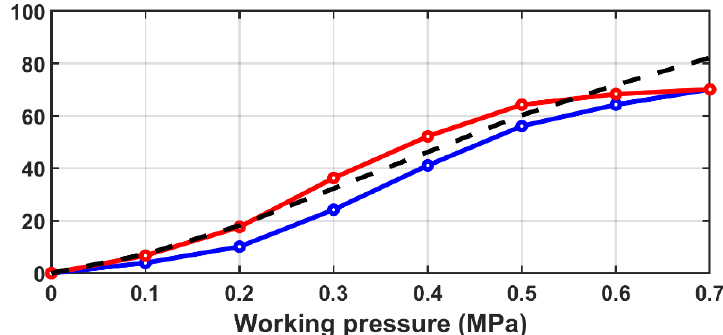
Figure 14. Diagram of correlation between the length contraction and working pressure for m = 5.0 kg: dashed line for theoretical modeling, blue line for experimental results of lifting a load, red line for experimental results of lowering a load.